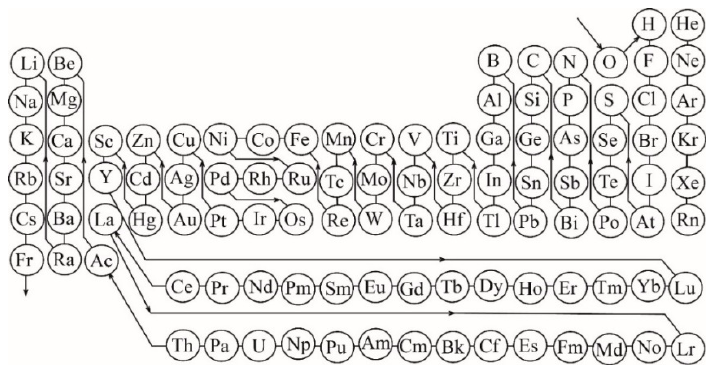
Figure 1. Thermochemical sequence of chemical elements. Arrows indicate the order of chemical elements used to identify a mineral system.